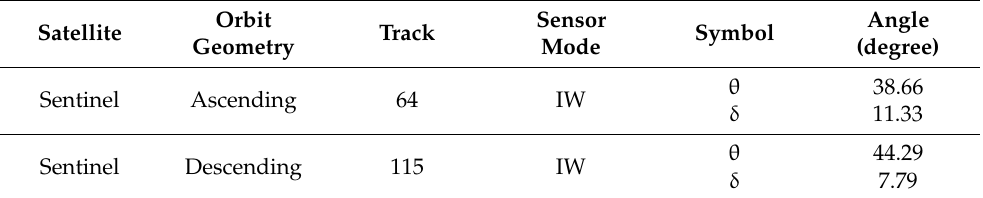
Table 1. Satellite viewing (LOS) angles for the Sentinel and Radarsat-2 imagery.